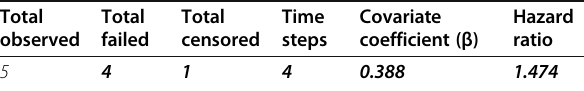
Table 10 The Cox model parameters